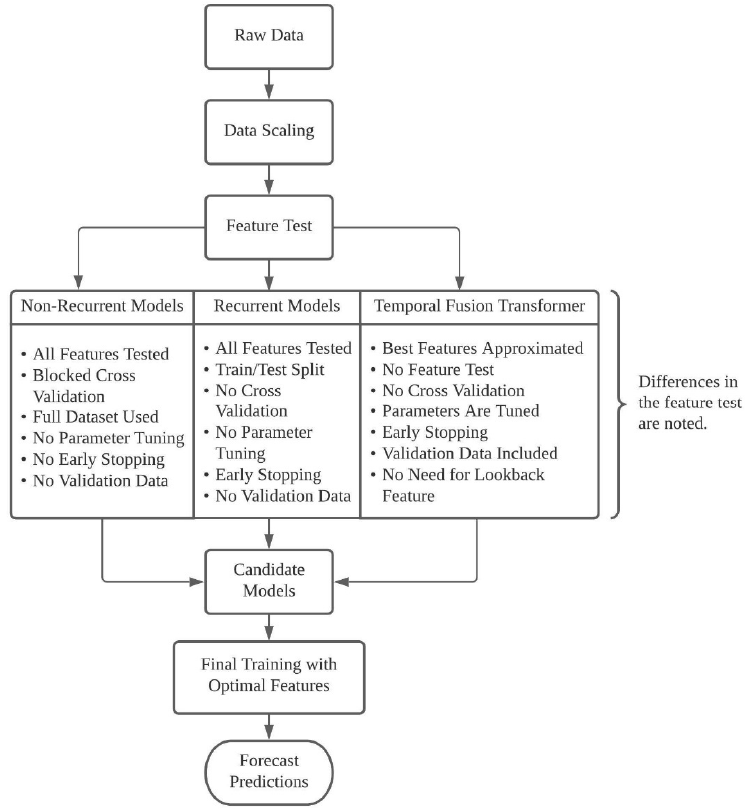
Figure 8. Model Training/Testing Flowchart. We display the lifecycle from raw preprocessed data to fully functional forecasting models. Collected raw data is organized as described in the text. Data scaling brings all features in line with one another. The feature test provides the optimal number of features. The best non-recurrent and all recurrent models move on for final testing. Beyond the increased class-size for one-week forecasting, the flowchart methodology is the same.